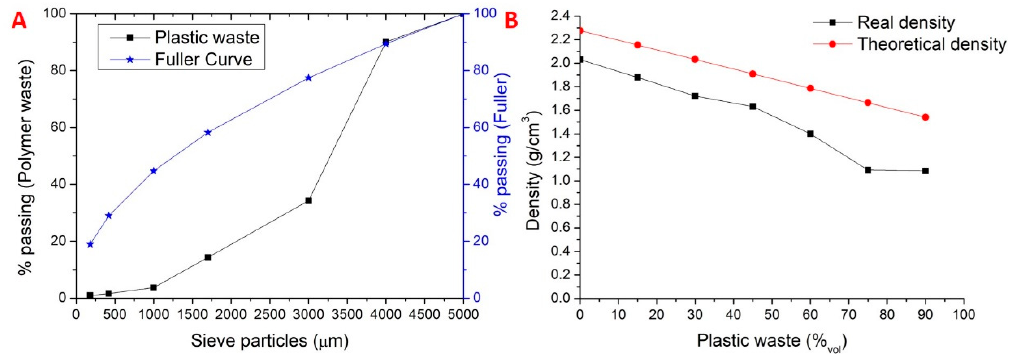
Figure 5. Fuller curve (in blue star) and cumulative granulometric distribution of plastic waste (in black square) ( A ) and variation of density as a function of the percentage of sand substituted with plastic waste ( B ).